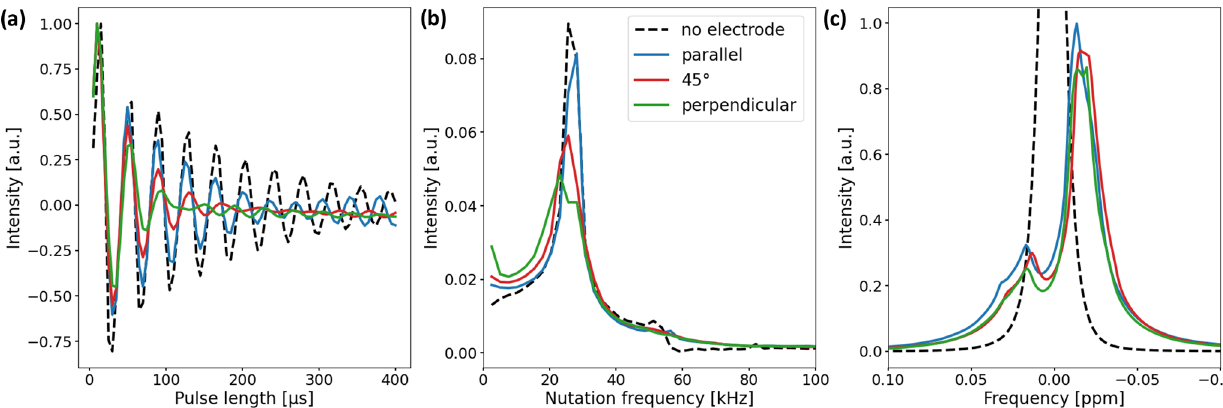
Figure 5. (a) Nutation curves of the 1 H water resonance using the in operando cell with electrode orientations of 0 ◦ (blue), 45 ◦ (red), and 90 ◦ (green). The nutation curve of a water sample without an electrode is shown for comparison (black dashed line). Deviations from the undistorted nutation curve are largest for the perpendicular electrode orientation and minimal for the parallel orientation. (b) Fourier transform of the nutation curves. The main component of the undistorted sample nutates at a frequency of 25.6kHz (15µs 90 ◦ pulse length). For the samples with electrode setups, the width of the main component increases and a low-frequency component appears. (c) 1 H water NMR spectrum with and without electrode setup. The B 0 field was not shimmed after electrode insertion. The signal shape is mainly governed by B 0 field distortions and only slightly affected by deviations in the B 1